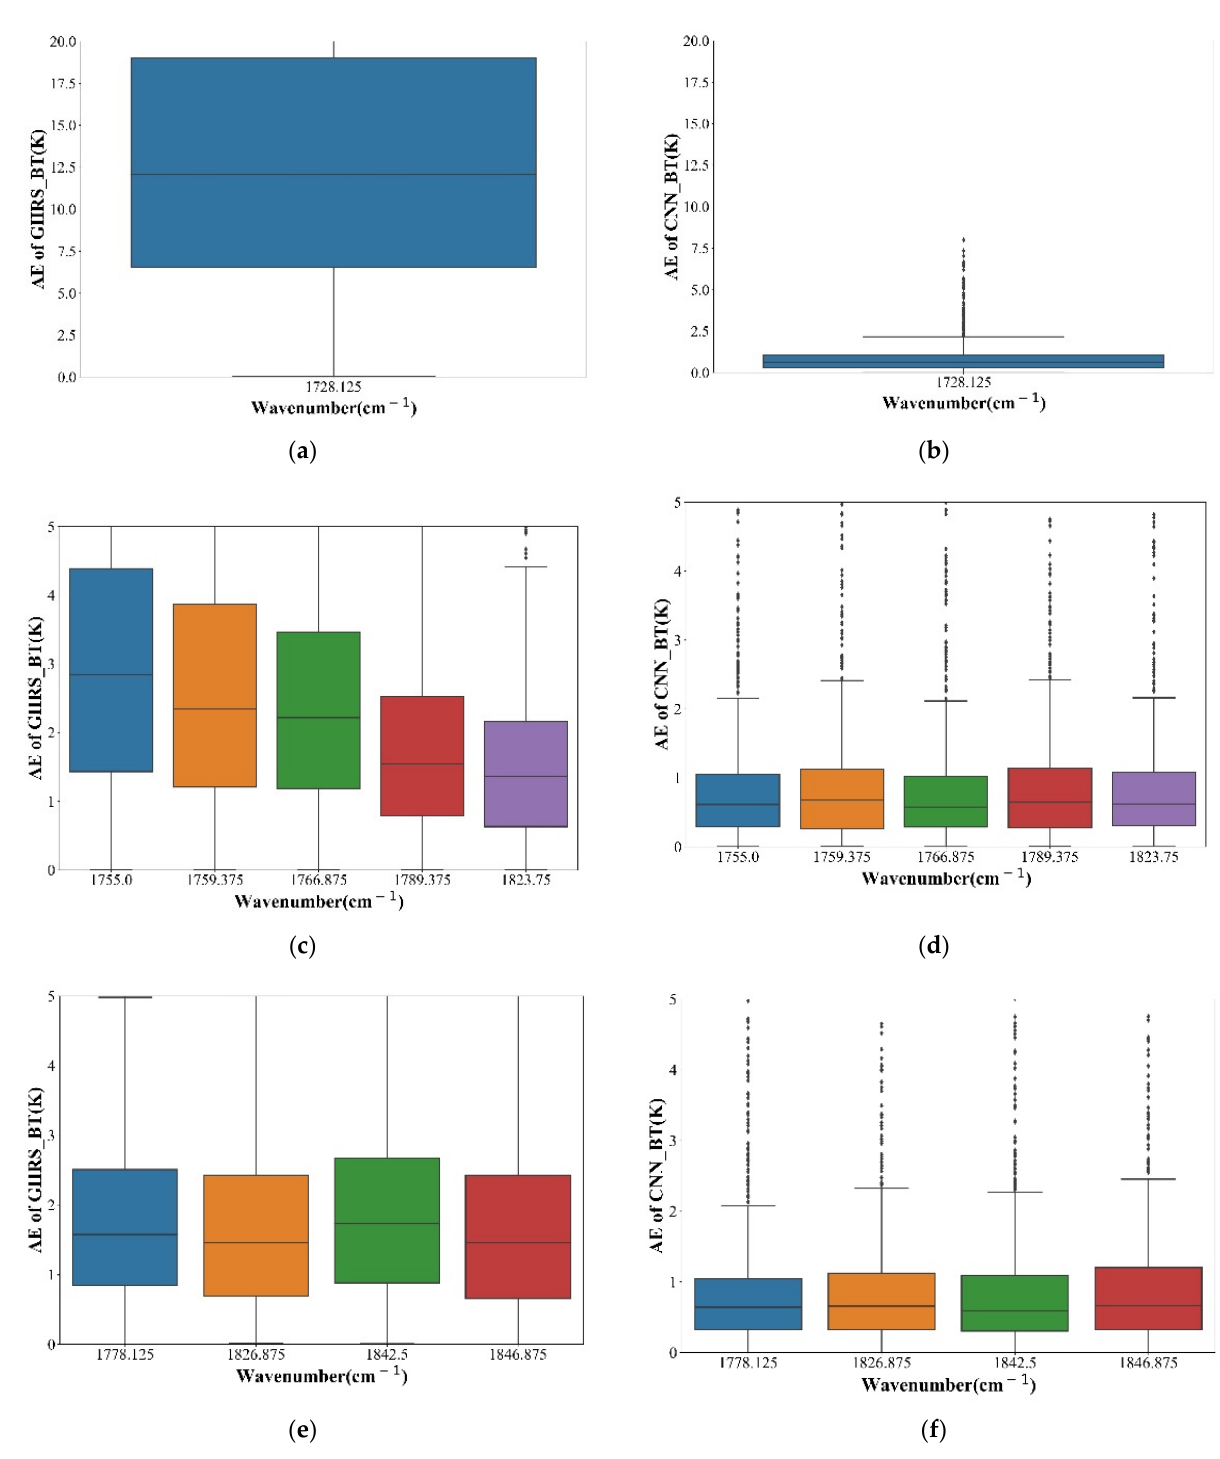
Figure 7. Box figures: ( a , c , e ) The absolute value deviation of GIIRS_BT and ERA5_RTTOV_BT for the test set. ( b , d , f ) The absolute value deviation of CNN_BT and ERA5_RTTOV_BT for the test set.